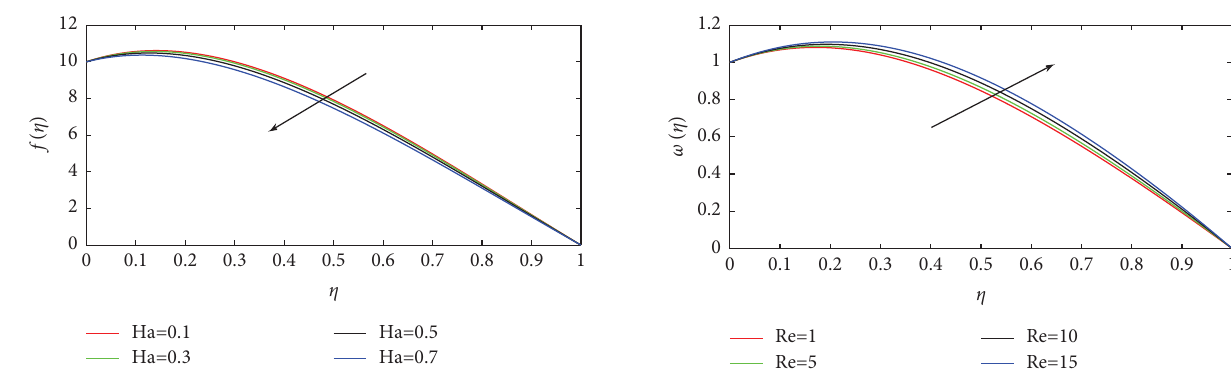
Figure 9: Temperature profles for the diferent values of Re.